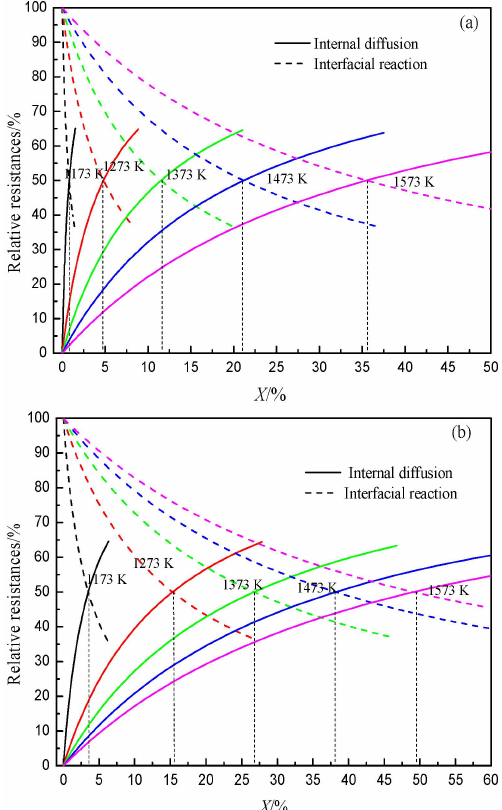
Figure 4. Relationship between reaction ratio and relative resistances at different temperatures, adopted from [49]. ( a ) Coke gasification by CO 2 ; ( b ) Coke gasification by H 2 O.